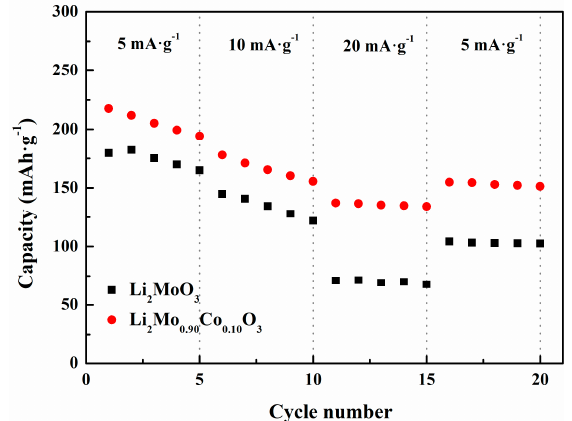
Figure 8. Rate performances of Li 2 MoO 3 and Li 2 Mo 0.90 Co 0.10 O 3 at different current density.